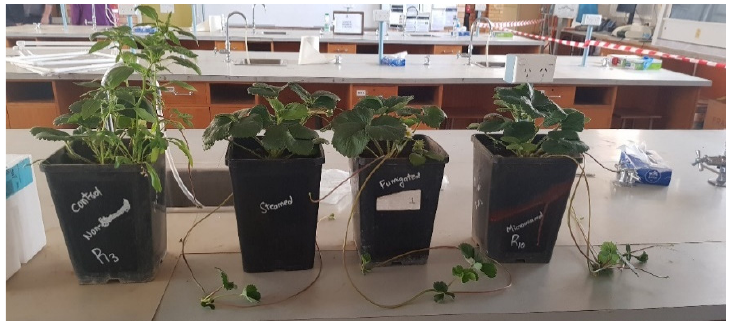
Figure 6. Subset of experimental pots illustrating differences between treatments, approximately six weeks after crop transplant. Note: The tall plant in the control pot on the left is a weed ( Amaranthus retroflexus ).